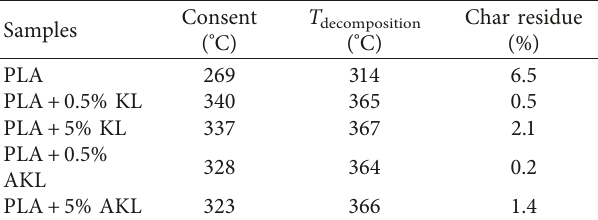
Figure 13: (a) XRD analysis of lignin-based rubber composite [187] (Copyright @ 2015 Wiley periodicals) and (b) wide-angle X-ray diffraction patterns of chitosan and composite materials with varying levels of lignin [9] (Copyright @ 2021 MDPI under CC BY 4.0). Table 3: Thermal degradation properties of PLA and lignin